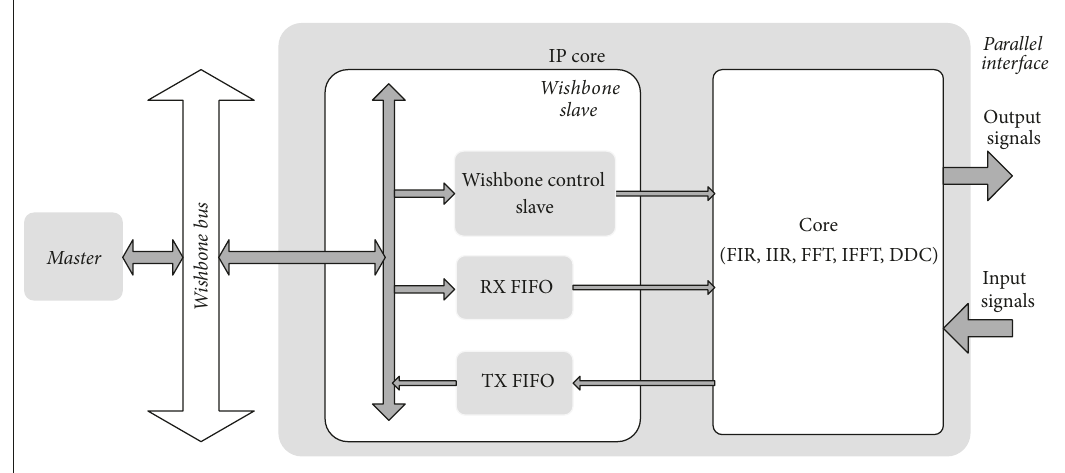
Figure 2: An overall architecture of a DSP IP